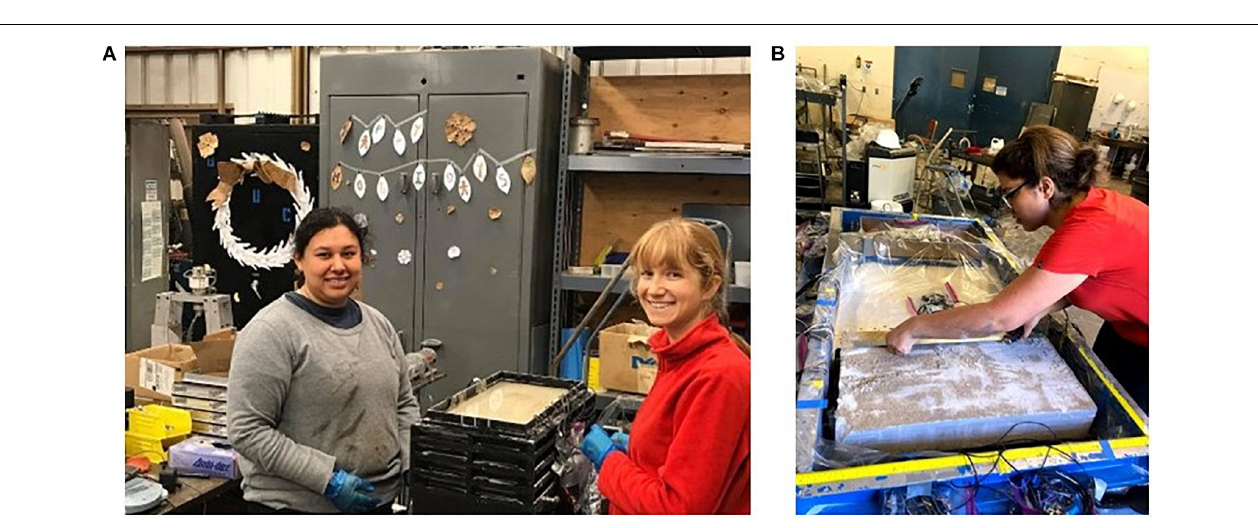
FIGURE 10 | Images of sand particles before and after MICP treatment (Reproduced from DeJong et al., 2006 with permission from ASCE).